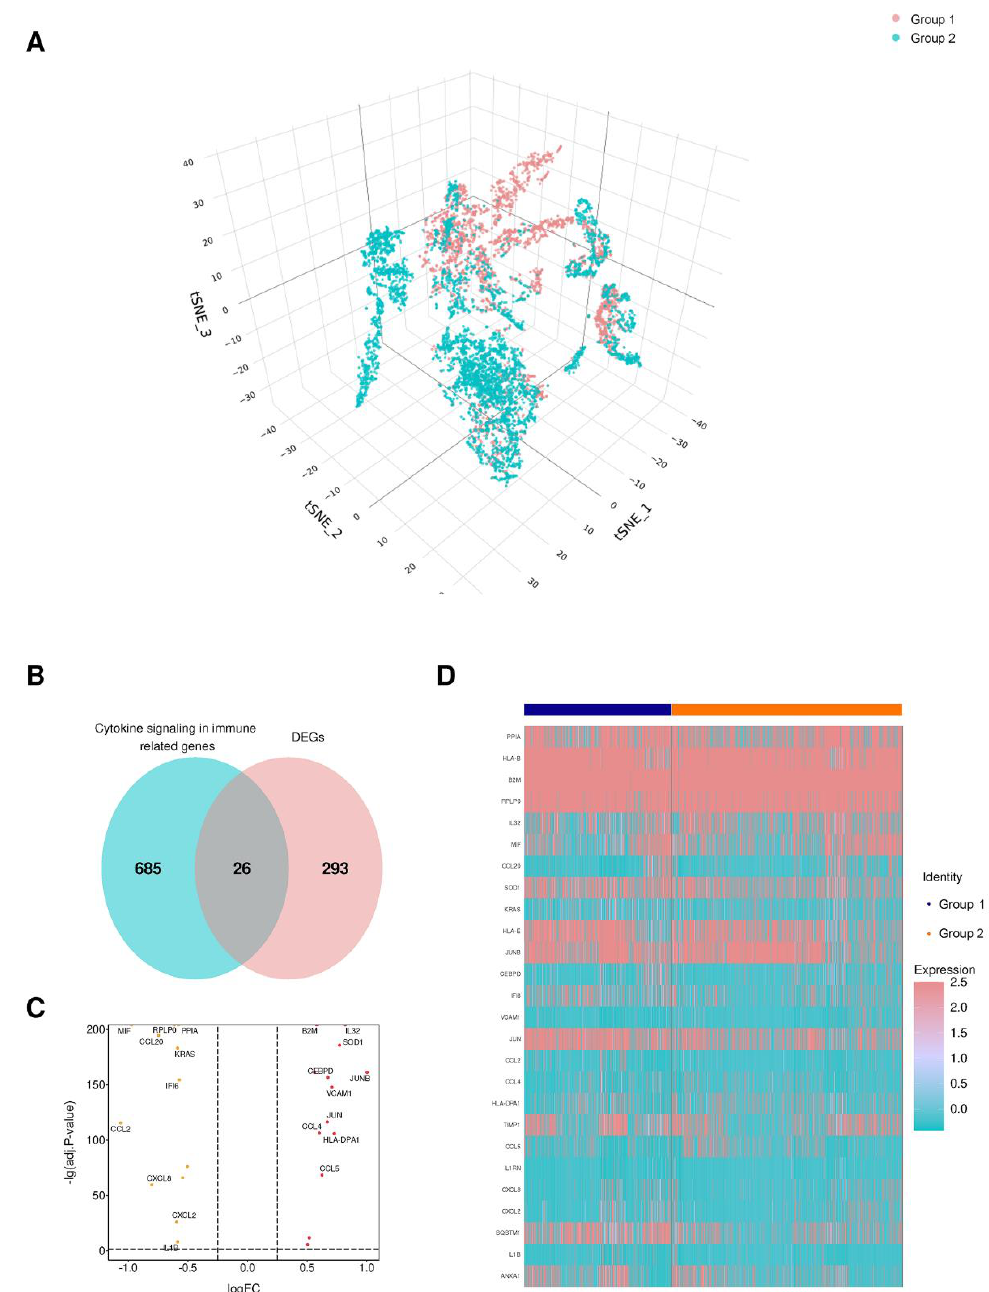
Figure 2. Identification of cytokine signaling in immune-related genes (CSIRG) in the GSE149614 dataset. ( A ) Nonlinear dimensionality reduction by the t-SNE algorithm. ( B ) Differentially expressed genes and CSIRG from Reactome. ( C ) A volcano map involving the up- and downregulated CSIRG. ( D ) The expression of 26 CSIRG in two cell populations. The primary HCC tissue was denoted as group 1, and metastatic HCC tissue was denoted as group 2.